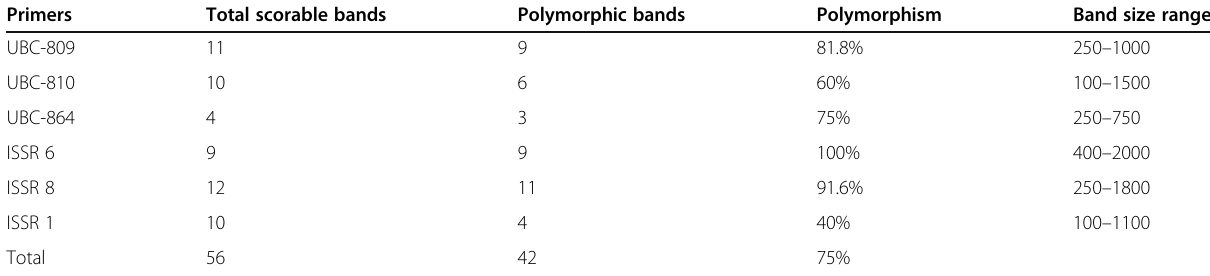
Table 3 Total number of scorable bands, polymorphism percentage, and band size of ISSR markers obtained by 6 primers Primers Total scorable